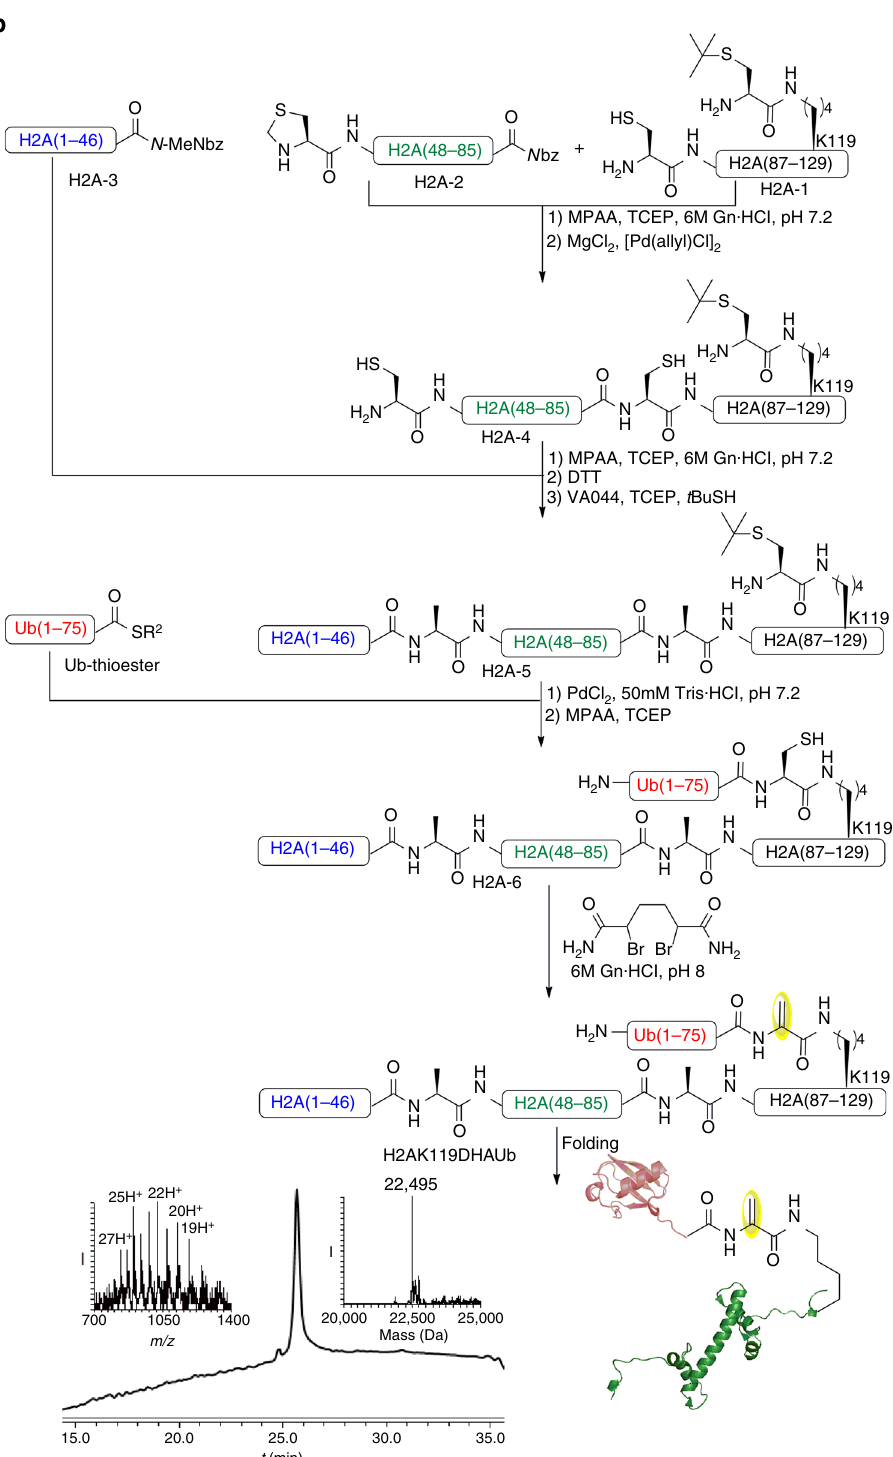
Fig. 5 Total chemical synthesis of H2AK119 DHA Ub. a The H2A sequence where the two-ligation sites are underlined. b Synthesis of H2AK119 DHA Ub and analytical HPLC and mass traces for puri fi ed H2AK119 DHA Ub with the observed mass 22495 ± 2.7 Da, calcd 22498 Da (average isotopes), H2A in green, ubiquitin in red. N -MeNbz: N -acyl- N -methylacylurea, N bz N -acyl-benzimidazolinone, R 2 3-Mercaptopropionate, VA044 2,2 ’ -Azobis[2-(2-imidazolin-2-yl) propane]